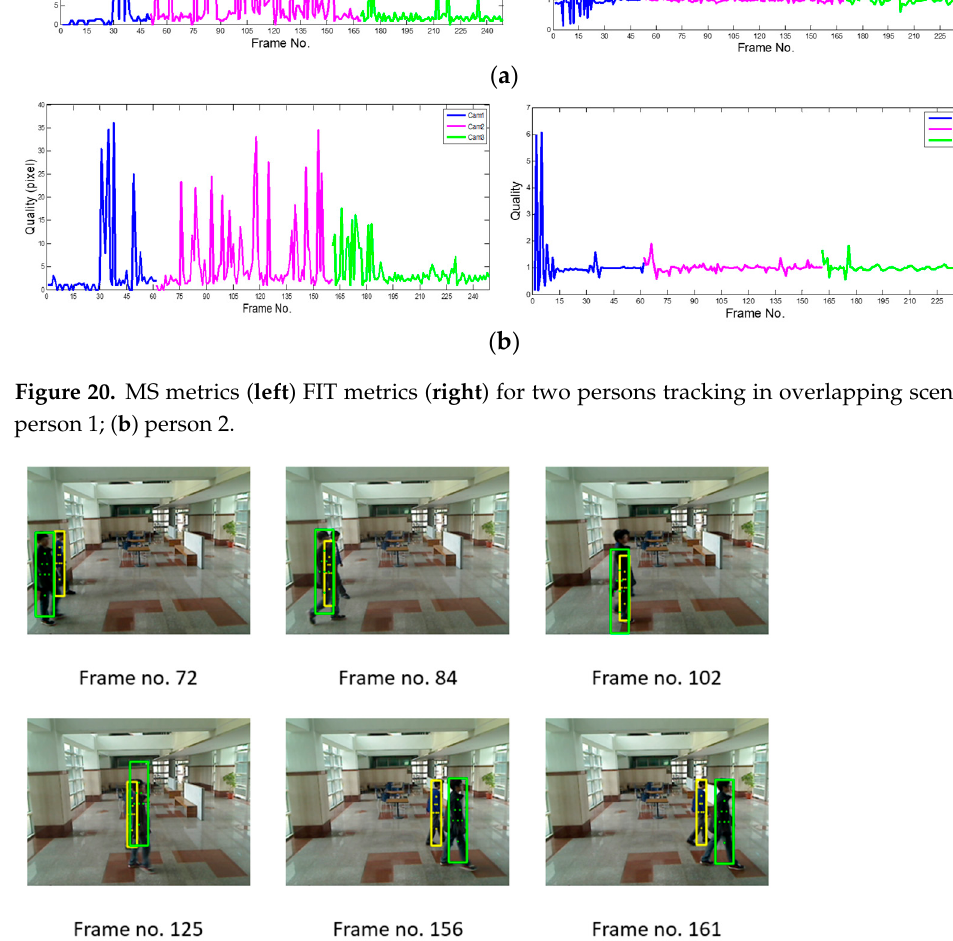
Figure 21. Two persons in overlapped transfer between cameras.